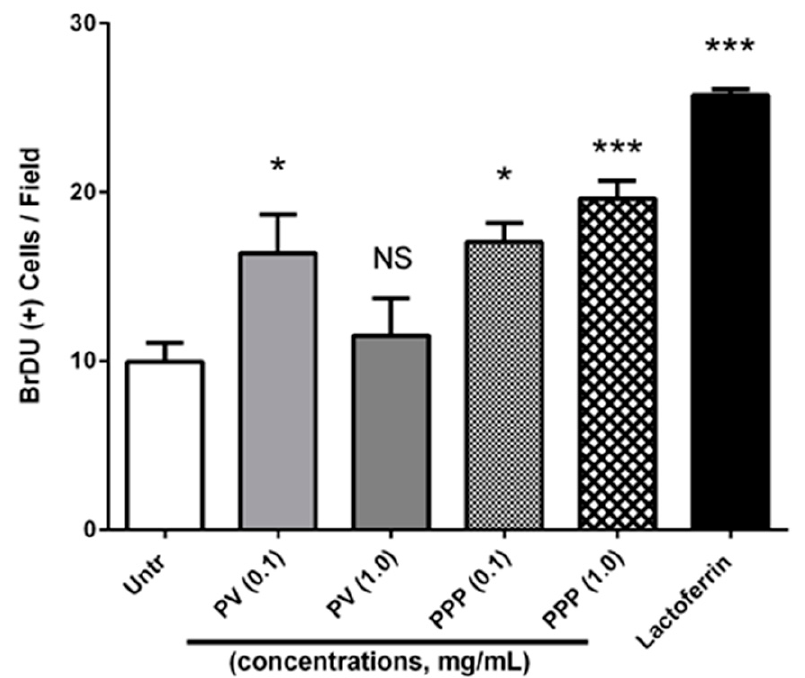
Figure 5. Phosvitin and PPP promote the proliferation of osteoblastic cells. Confluent monolayers of MC3T3-E1 cells were treated for 24 h with different concentrations (0.1 and 1.0 mg/mL) of phosvitin (PV) or PPP prior to being treated with the BrDU reagent, fixed, permeabilized and immunostained for BrDU. Cell nuclei were counter-stained with Hoechst33342 dye. The percentages of BrDU(+) nuclei